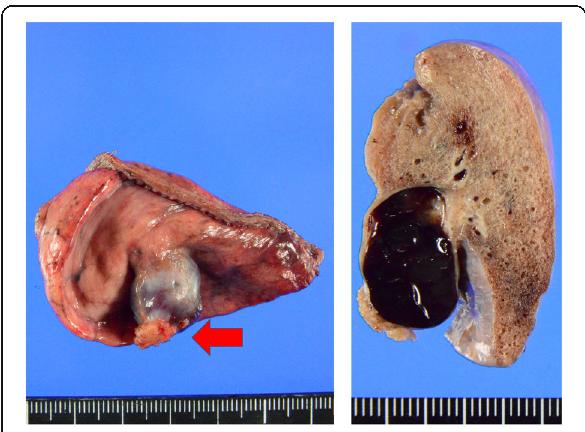
Fig. 3 Resected left lower lobe specimen. The PAVM protruded into the pleural cavity. The ruptured region was covered by pericardial fat (red